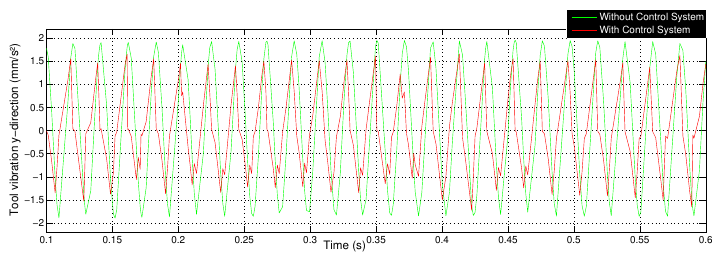
Figure 5. Tool vibration along y -direction using DSMC.